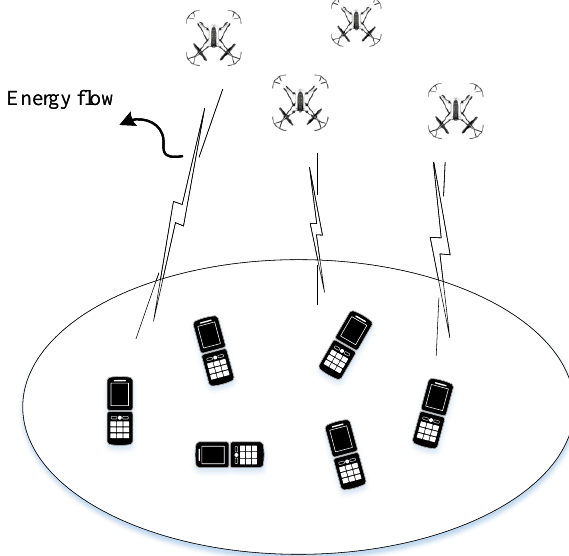
Figure 1. The system model of UAV-aided WPT.